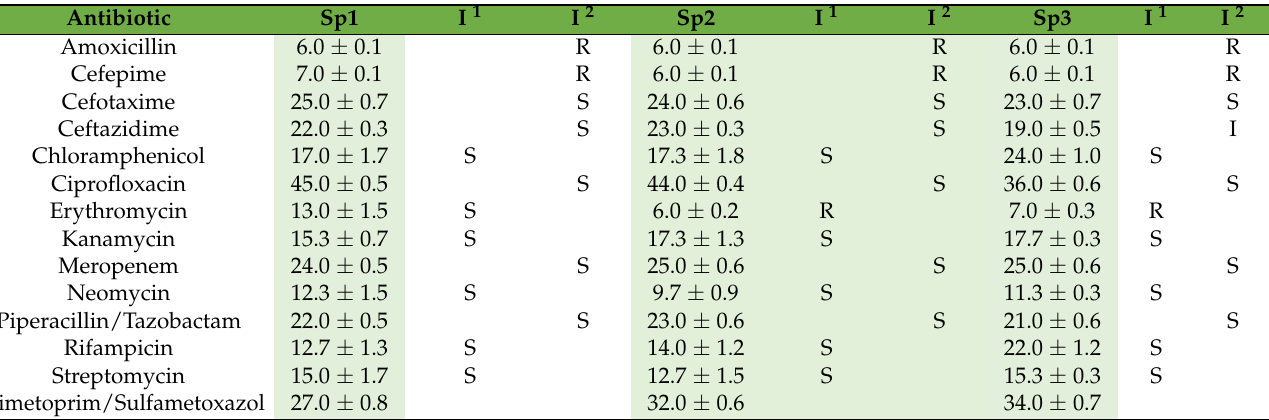
Table 4. Intrinsic antibiotic resistance of the different S. plymuthica strains, isolated from fava bean and pea nodules, determined using the disc diffusion method on solid MH medium. Values indicate the halo diameter (mm) (mean and standard errors, n = 3 dishes).